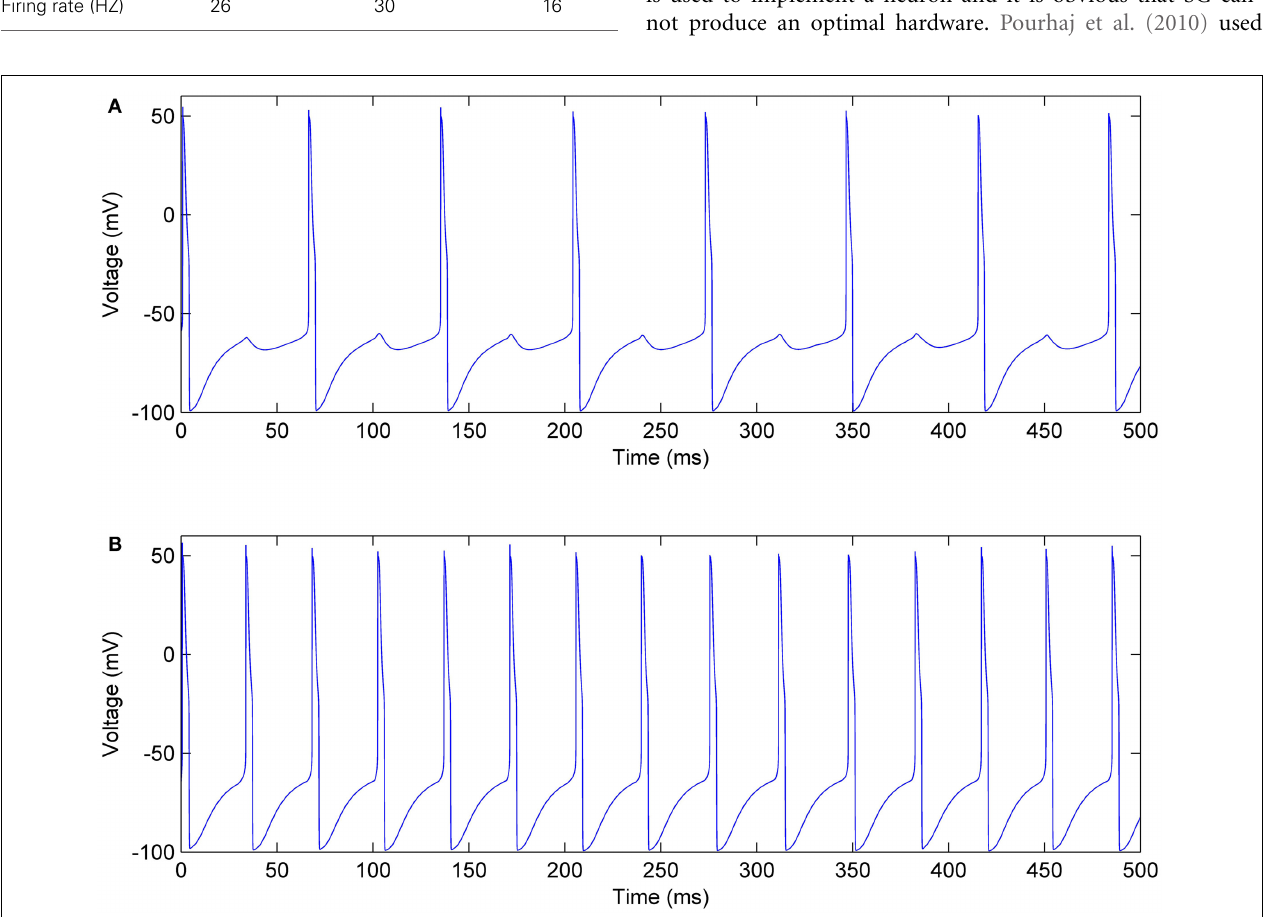
FIGURE 12 | Membrane voltage of one of the neurons, (A) In the excitatory pool, (B) In the inhibitory pool of a mini-column.